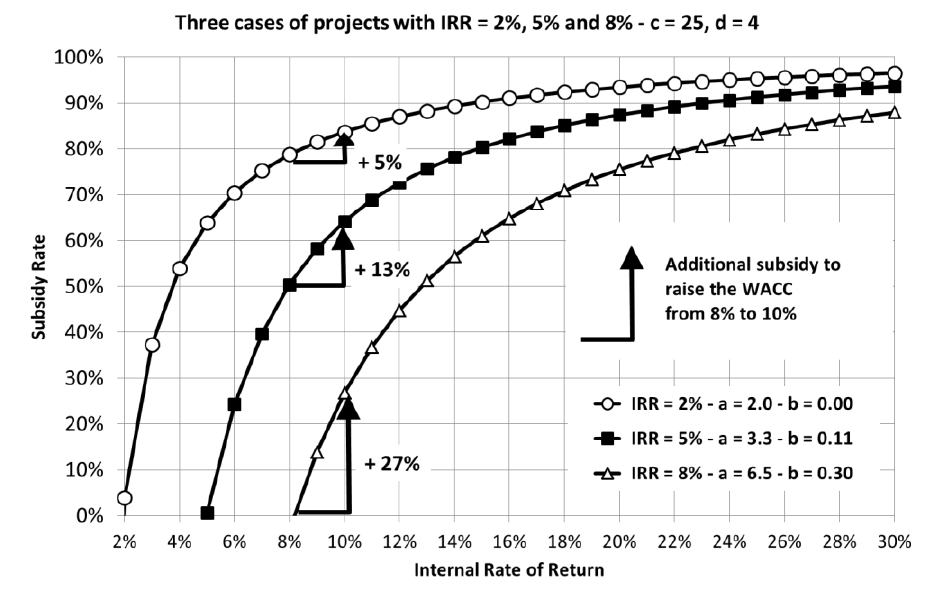
Figure 2. Intrinsic IRR, subsidy rate and targeted